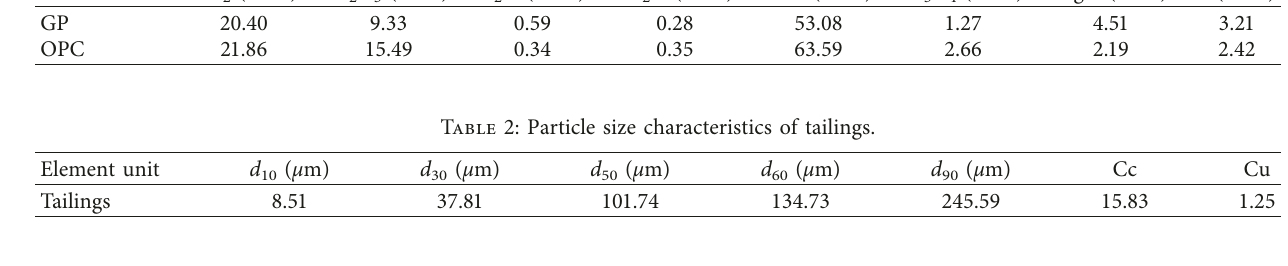
Table 3: Main chemical constituents of the